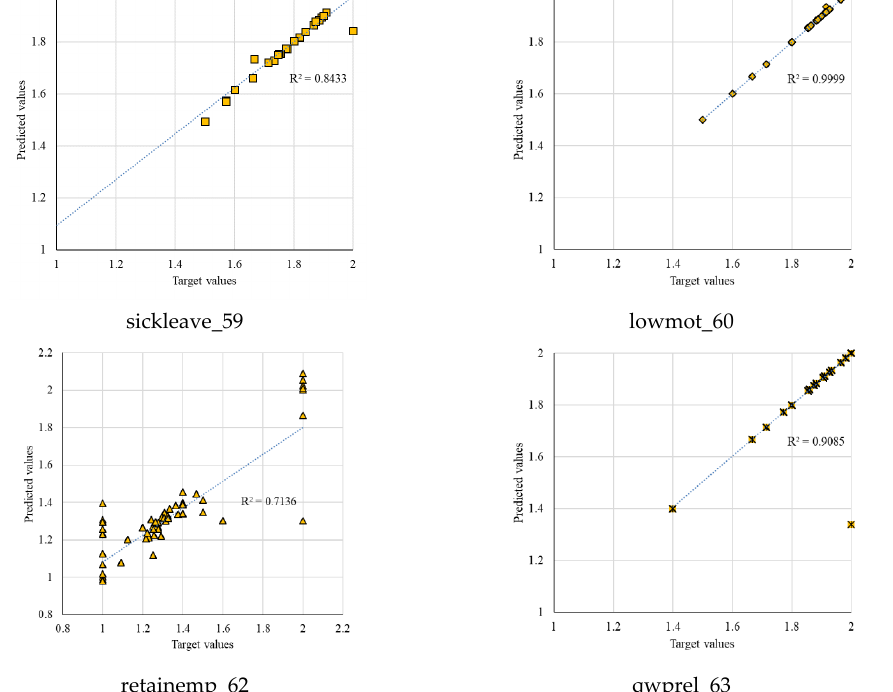
Figure 6. Plot diagrams for the effects of skills requirements and skill matches on output values of employee wellbeing. The mean value of linearity for predicting firm performance using skills require- ments and skill matches is approximately 67%, which is about 19% lower than that for predicting employee wellbeing. According to this tendency, the impact of skills re- quirements and skill matches-related characteristics on firm performance is around 22% lower than the impact of those same factors on employee wellbeing.